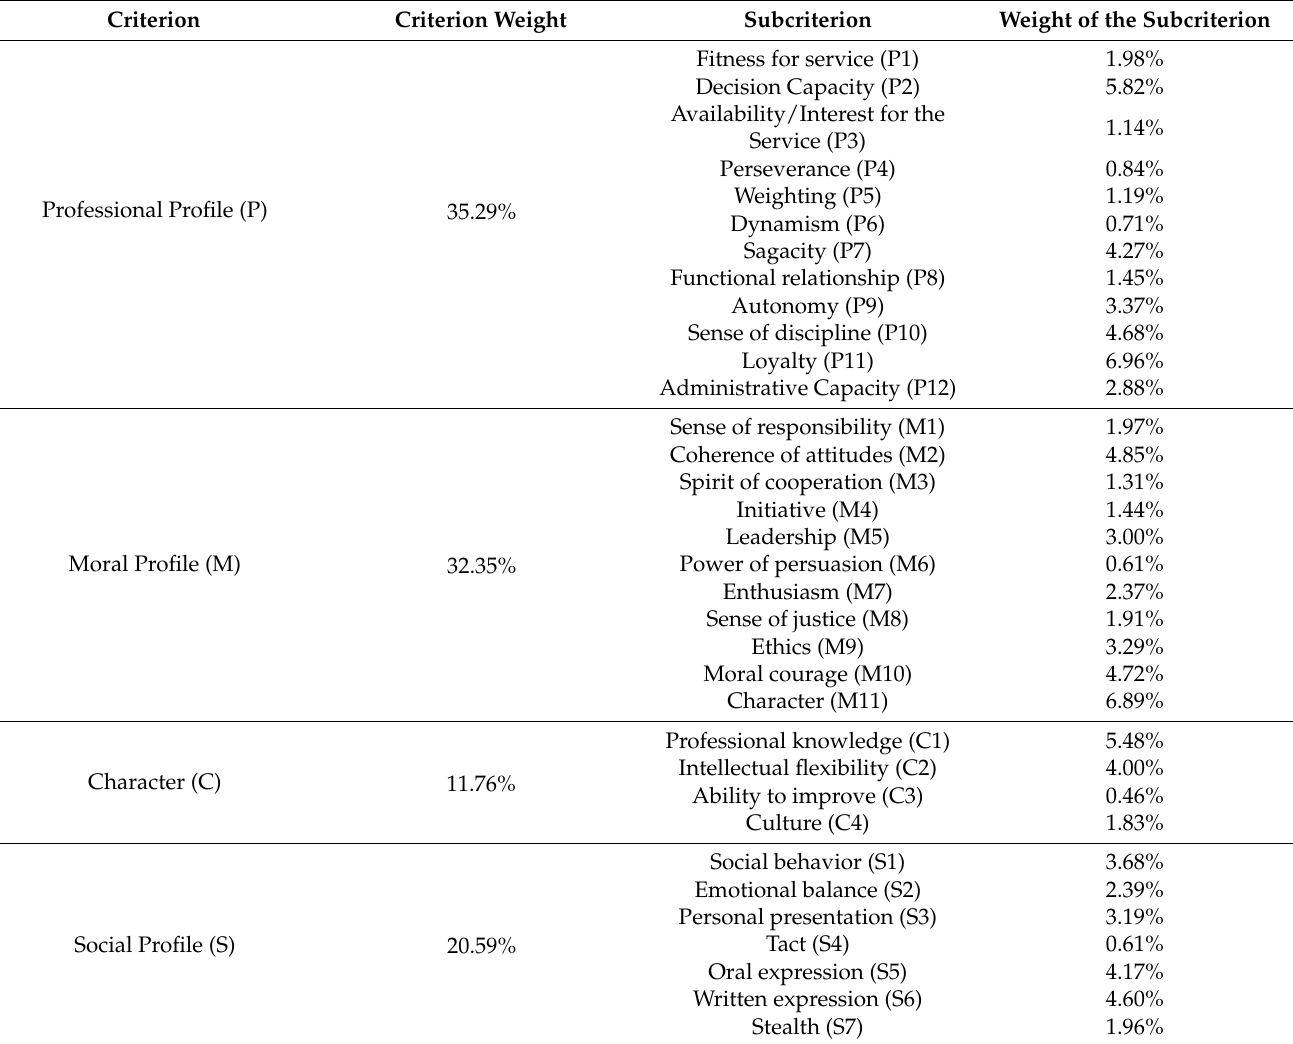
Table 9. Global weights of the